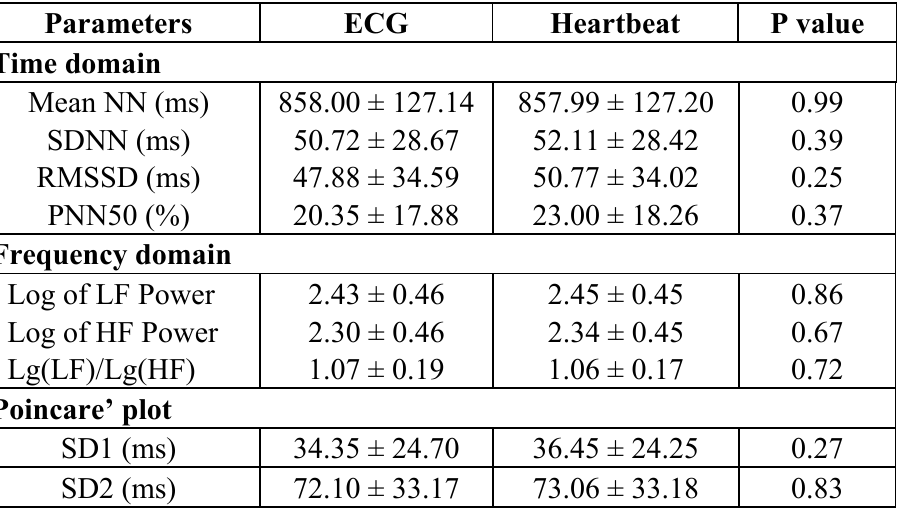
Table 1 The comparison of the parameters in time domain, Frequency domain and Poincaré plot derived from ECG and Heartbeat for group of subjects (n = 16) using one-way